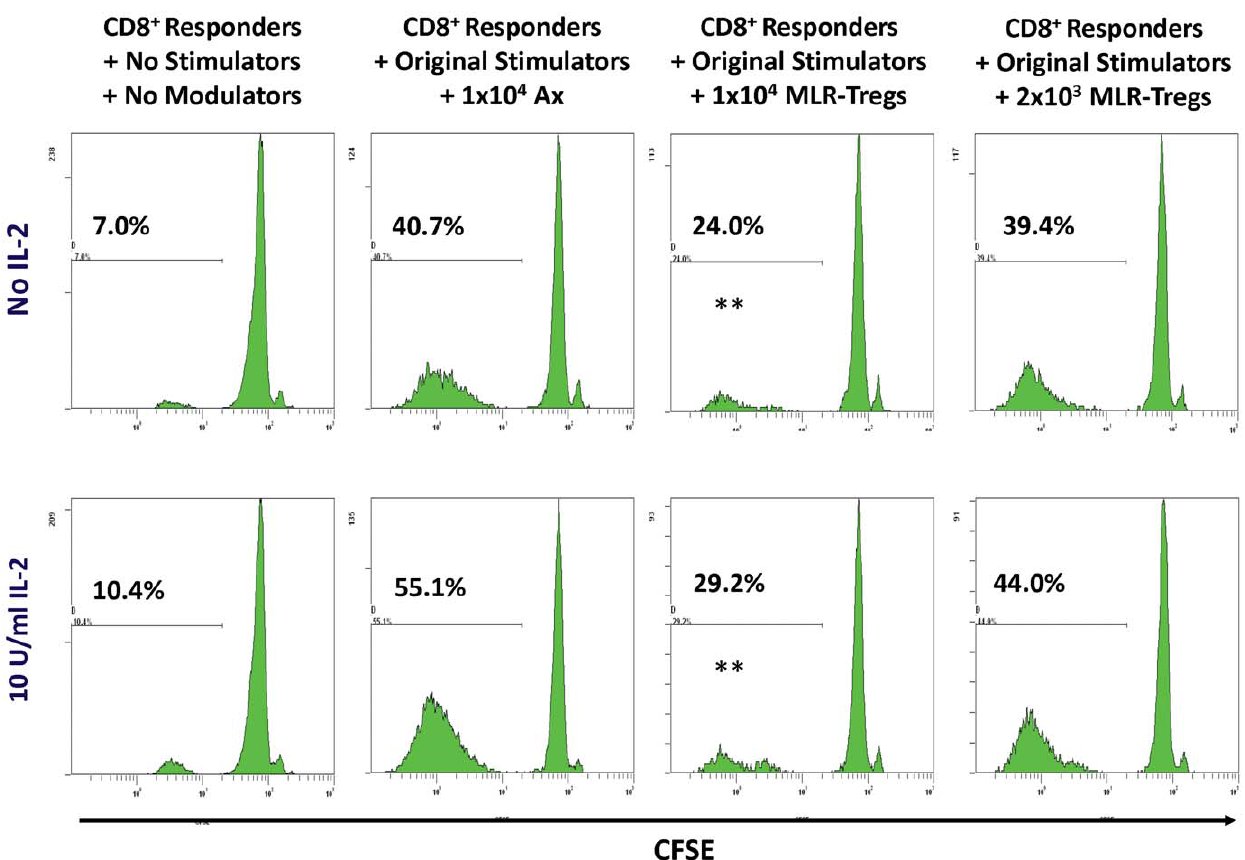
Figure 8. MLR-Tregs suppress purified CD8 allospecific proliferation. 5 6 10 4 CFSE labeled purified CD8 cells were cultured with 1 6 10 5 irradiated PBMC from the original stimulator (used in generating MLR-Tregs) together with indicated numbers of autologous MLR-Treg modulators or autologous irradiated controls (Ax), either the presence (top row) or absence (bottom row) of IL-2 (10 U/ml). After 7 days in culture flow cytometric assays were performed and the percentage of CFSE-diluted cells was estimated after gating on viable lymphocytes followed by CD8 + cells. It was observed that the irradiated stimulators and Ax died off by day 7 (not shown); even the few that remained were gated out on CFSE vs. CD8 density- plot during the analysis. Note the increasing percentages of (CFSE diluted) proliferating cells with decreasing concentrations of the MLR-Treg modulators. In the left column are depicted the results of negative control cultures (CD8 responders) in the absence of allogeneic stimulators or modulators. The figure is representative of 3 such experiments. (**=p , 0.01;